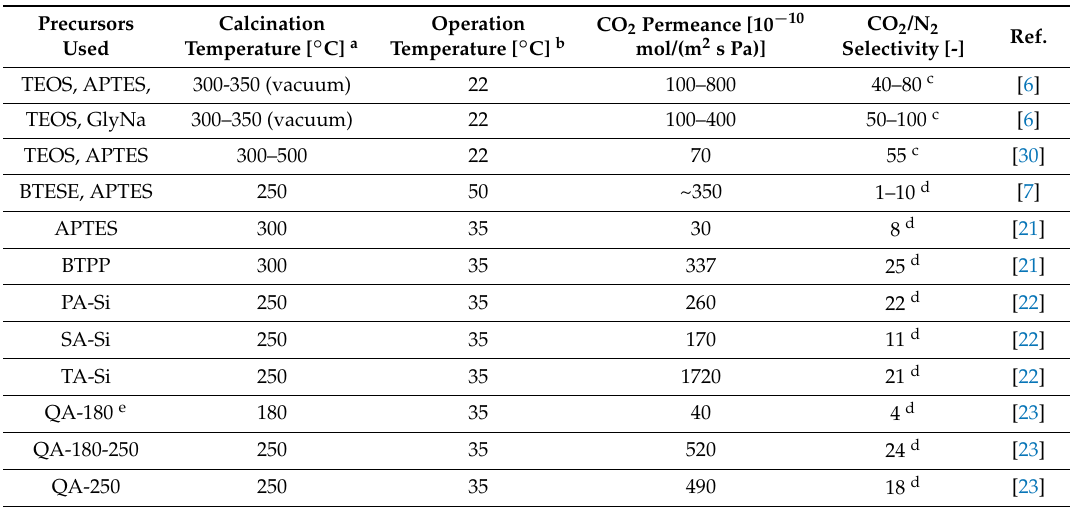
Table 1. Summary of synthesis conditions and membrane performance for reported amine-functionalized silica-based membranes fabricated via a sol-gel